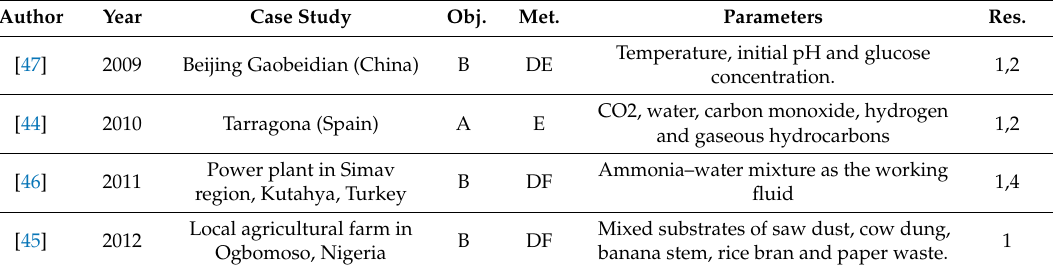
Table 5. Reviewed ANN studies on Other